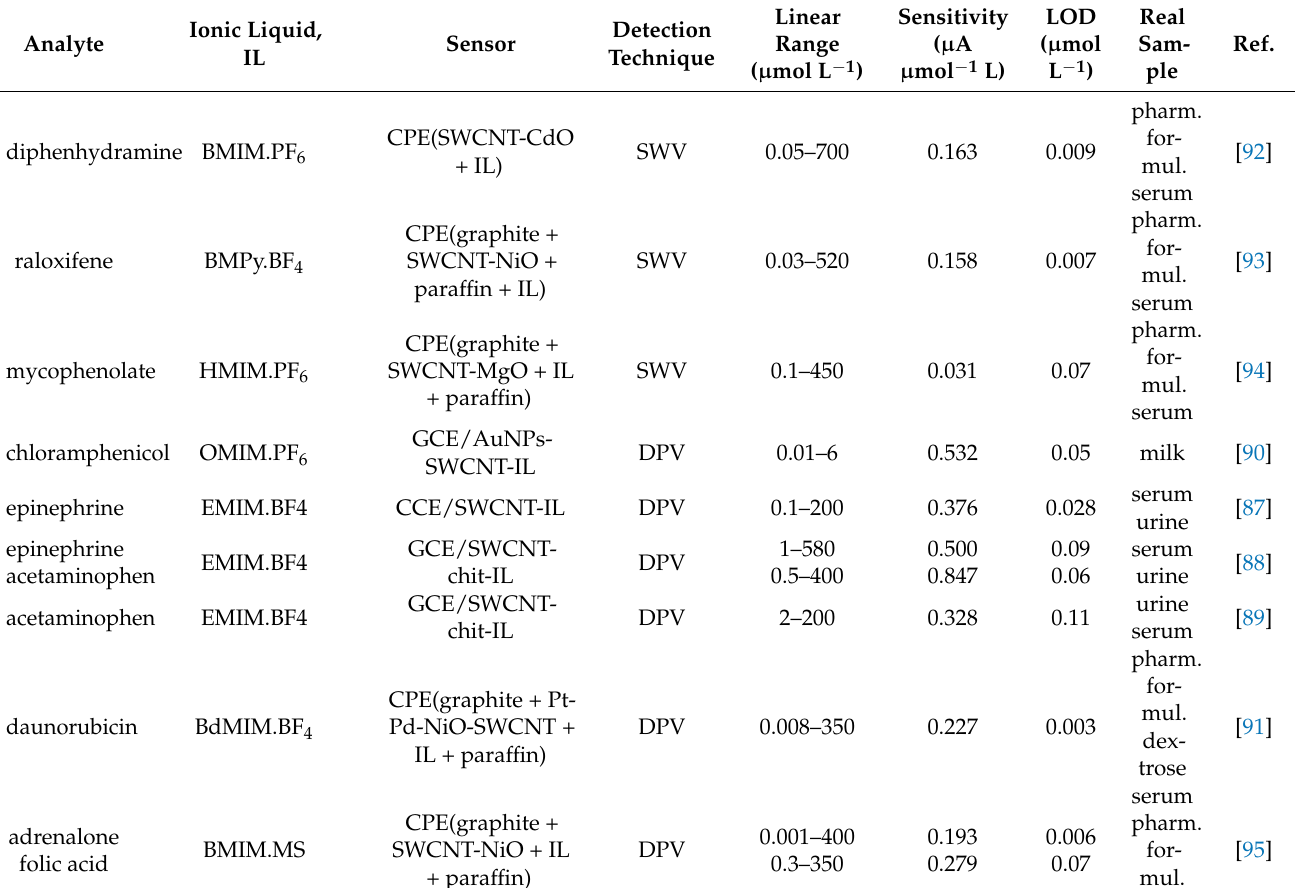
Table 2. Electrochemical sensors developed from SWCNT-IL-based nanocomposites for pharmaceuti- cal